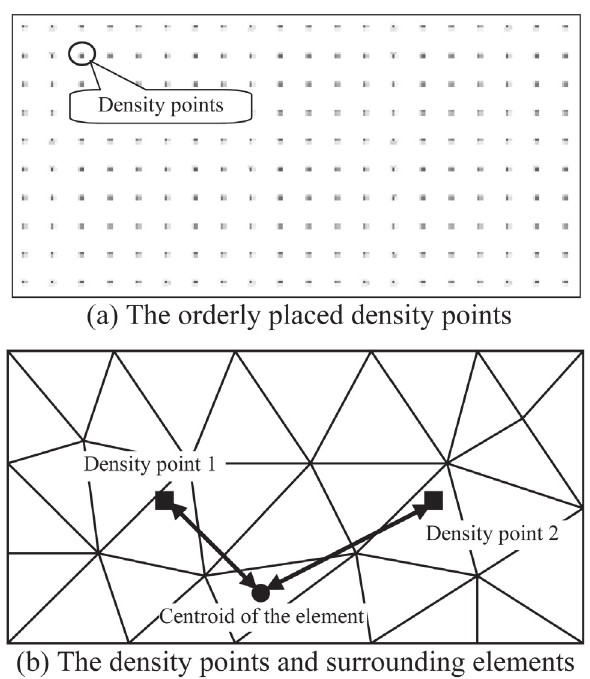
Fig. 10. Introduction of the density points.